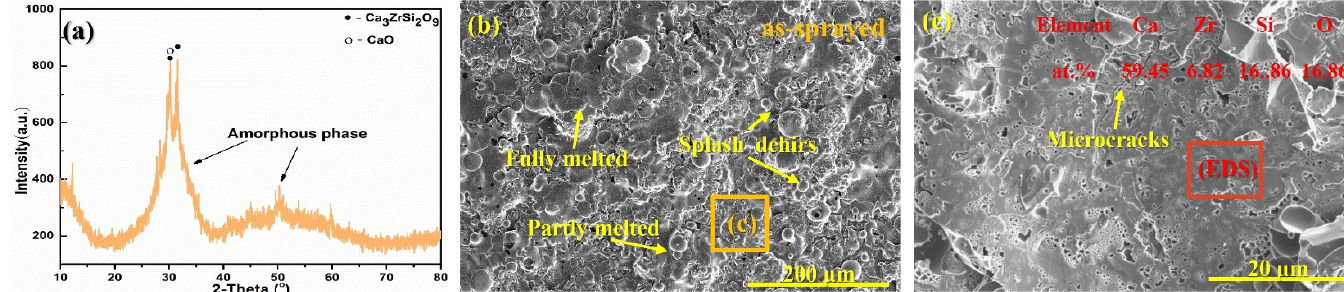
Figure 3. XRD pattern ( a ), surface morphologies ( b , c ) and EDS results of as-sprayed CZSO coating.